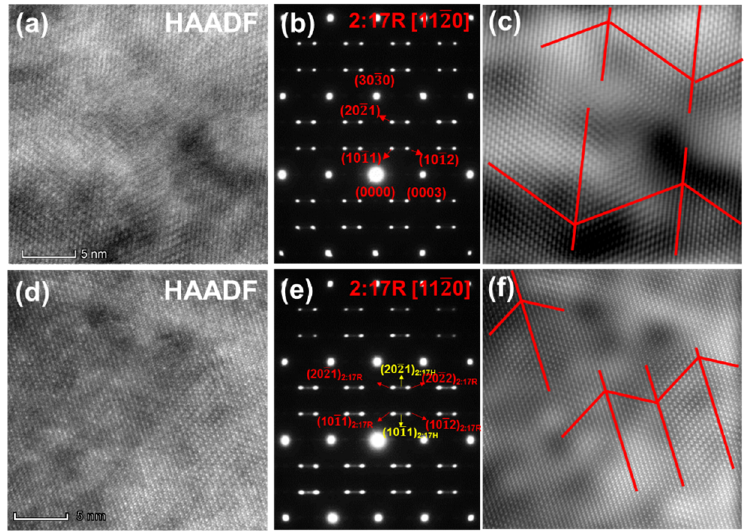
Figure 6. The original magnet isothermal aged for 1 min viewing along [1120] 2:17R ( a ) HRSTEM-HAADF, ( b ) SAED patterns, ( c ) inversed fast Fourier transformation (IFFT) images for the magnet with 0.5 wt.% addition isothermal aged for 1 min viewing along [11 2 0] 2:17R , ( d ) HRSTEM-HAADF, ( e ) SAED patterns, ( f ) IFFT images.